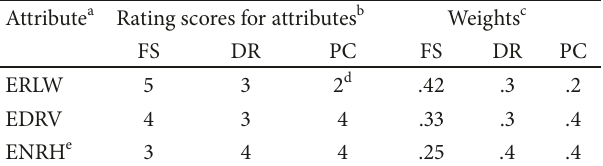
Table 1: Derivation of baseline weights for attributes of FTSs for Forest Service (FS), Department of Natural Resources and Conservation (DR), and Plum Creek Timber Company (PC).